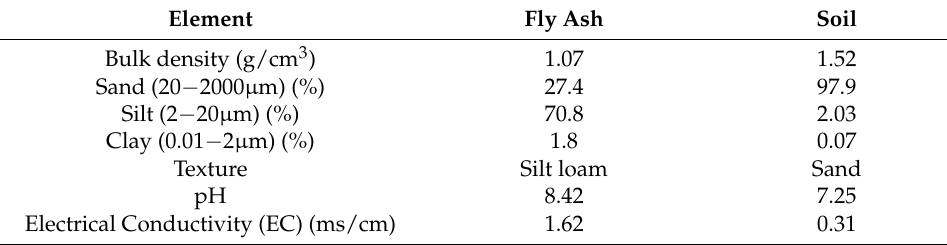
Table 2. Physicochemical properties of the fly ash and soil used in the